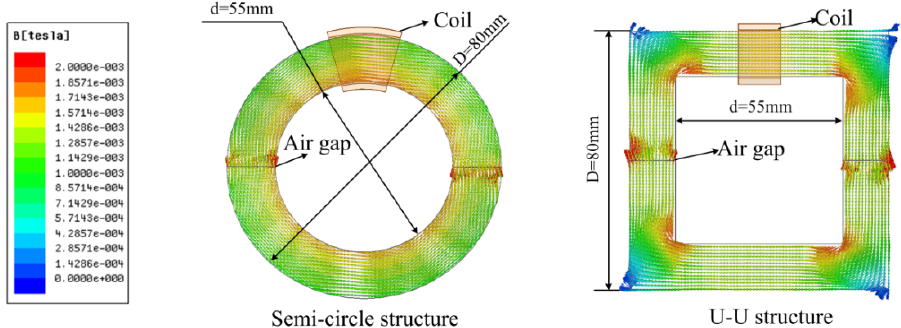
Figure 3. Distribution of magnetic field of the semi-circle and U-U structure core (semi-circle core: D = 80 mm, d = 55 mm, air gap = 0 mm; U-U structure core: D = 80 mm, d = 55 mm, air gap = 0 mm).